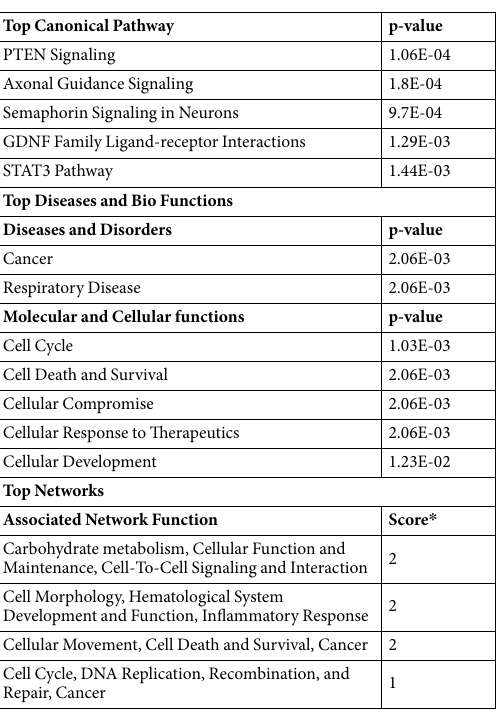
Table 1. Summary of PamGene IPA analysis. * The score of top networks is simply a measure of the number of genes significantly different from CBL WT or Mts in a